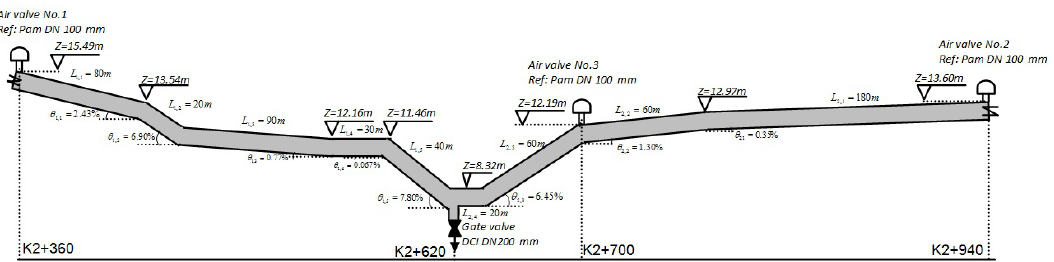
Figure 3. Profile—Ciudad del Bicentenario pipeline.